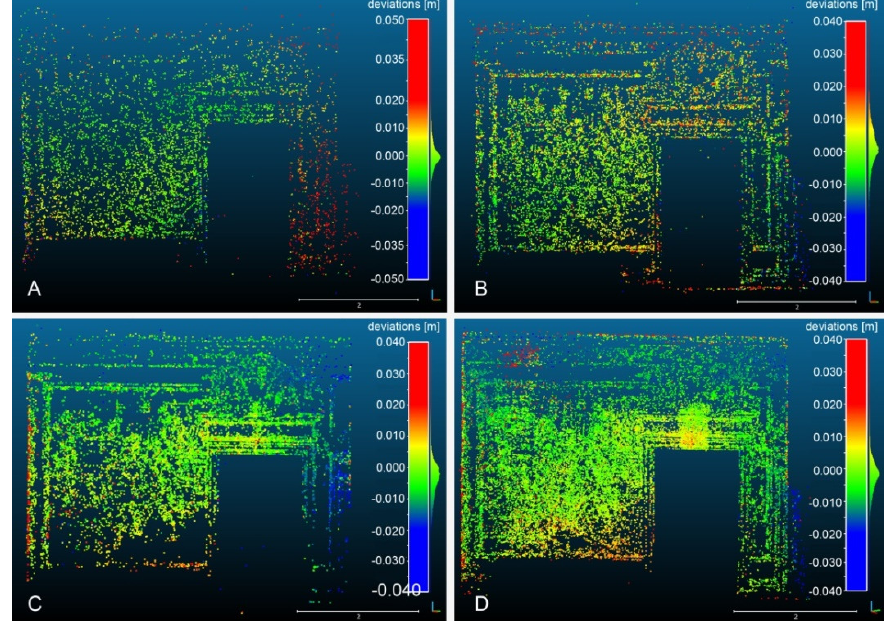
Figure 8. Map of SfM point deviation from a fitted plane: a) Xiaomi 2k (based on 68 images), b) Xiaomi 4k (based on 76 images), c) Hasselblad Hd-50 (based on 41 images), d) Canon 5D Mark II (based on 80 images)